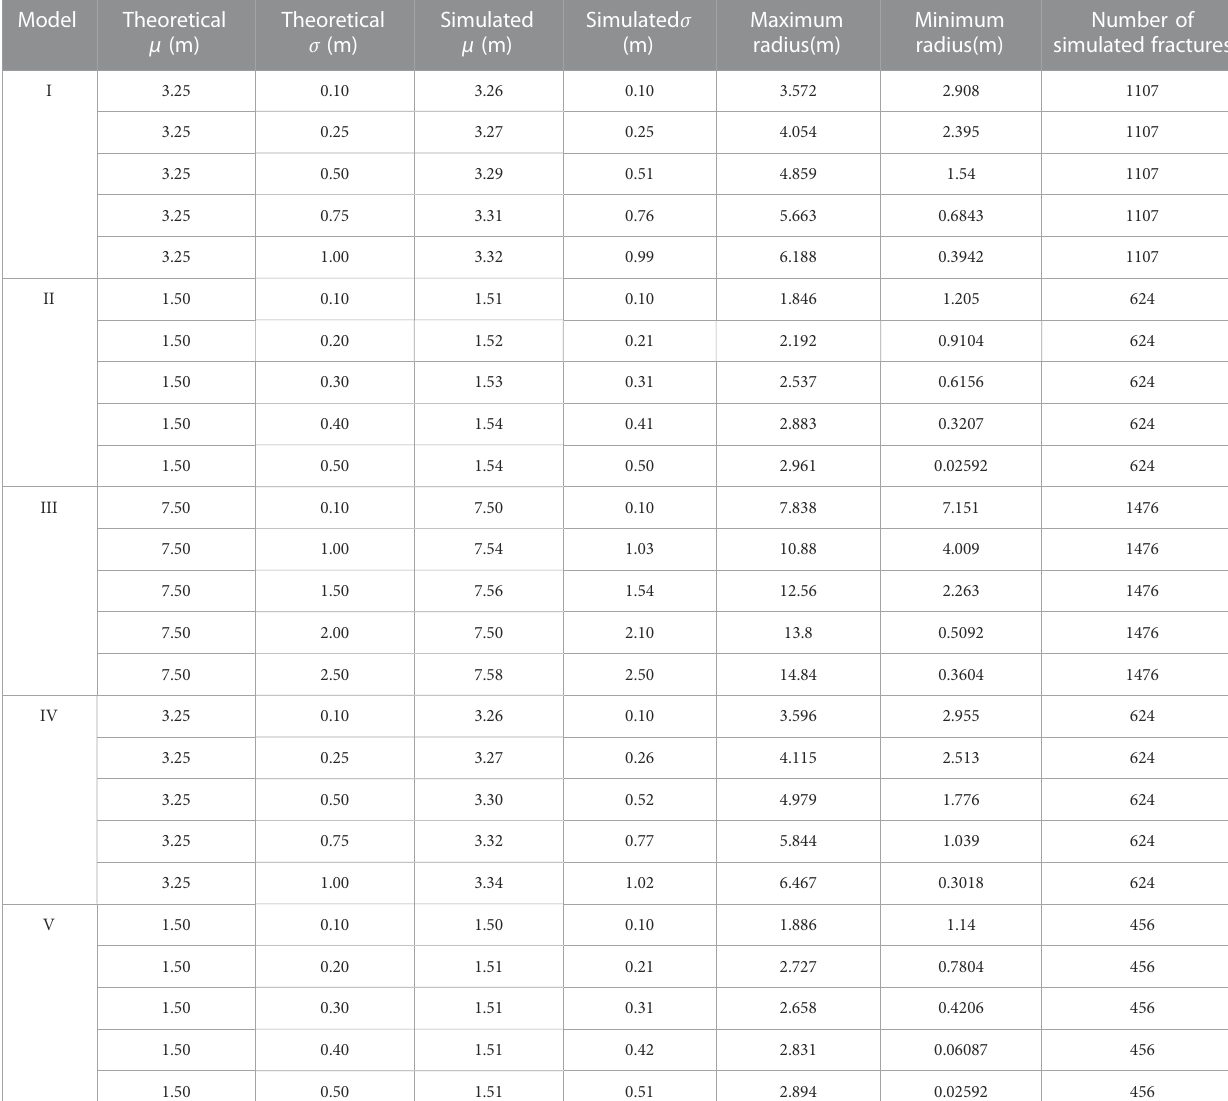
TABLE 3 Comparison between theoretical and simulated fracture radii in each model. Model